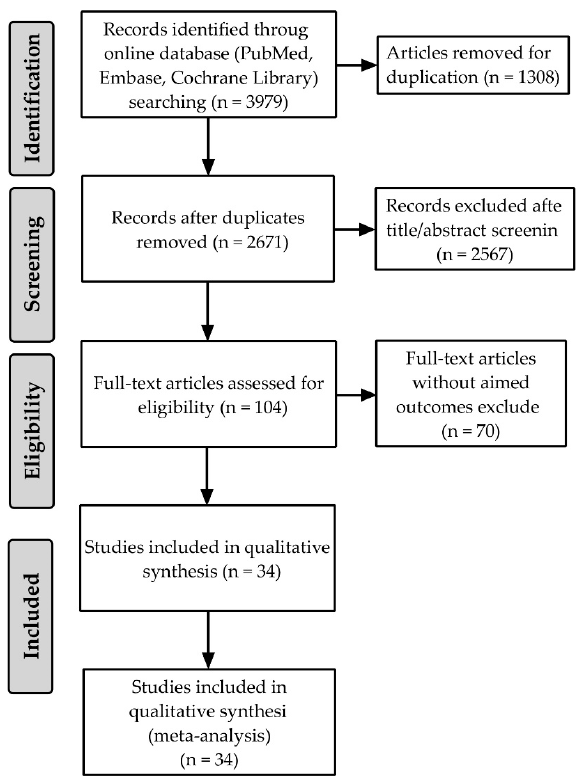
Figure 1. Flow chart of systematic literature search for RCT, published through March 2022, that met the study inclusion and exclusion criteria.